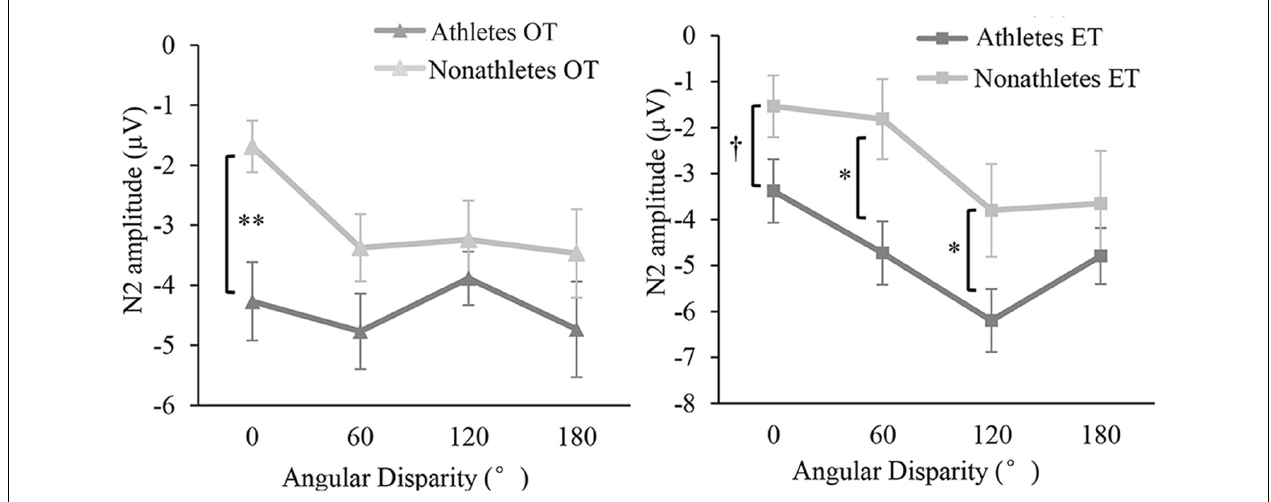
FIGURE 3 | The peak amplitude of N2 as a function of the angle at Pz per group in OT and ET conditions (M ± SE). In the left panel, the dark gray line with the triangle denotes the athletes in the OT condition, and the light gray line with the triangle denotes non-athletes in the OT condition. In the right panel, the dark gray line with the square denotes the athletes in the ET condition, and the light gray line with the square denotes non-athletes in the ET condition. † p < 0.1, ∗ p < 0.05, ∗∗ p < 0.01.